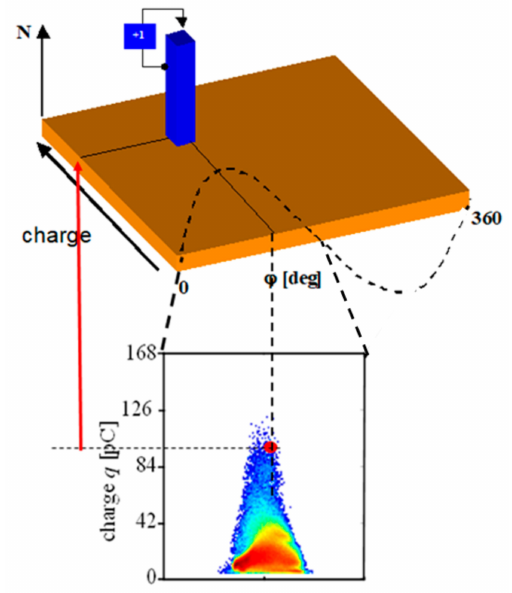
Figure 1. Partial discharge phase-resolved